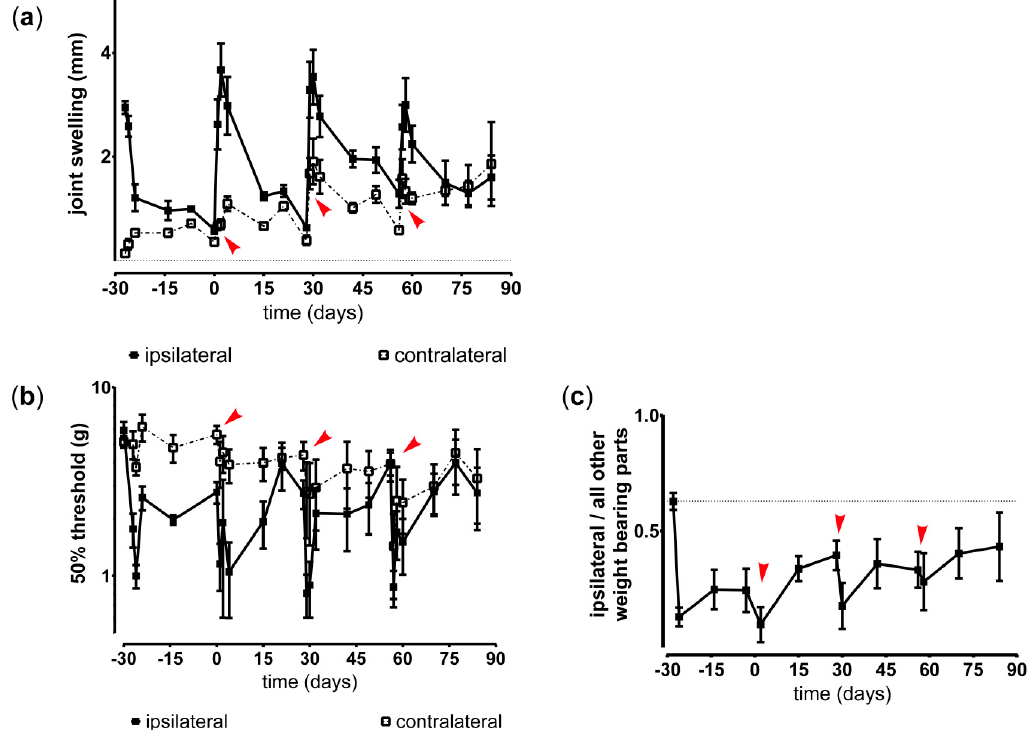
Figure 3. Inflammation and hyperalgesia induced by streptococcal cell wall peptidoglycan polysaccharide (PGPS) reactivations in a modified model enabling long-term monitoring of pain. ( a ) Joint swelling, as indication of inflammation, was measured in untreated affected (ipsilateral) and contralateral (contralateral) knee joints. PGPS reactivations on day 0, 28, and 56 are indicated by red arrows. ( b ) Withdrawal threshold of the induced mechanical hypersensitivity in untreated affected (ipsilateral) and contralateral (contralateral) knee joints. PGPS reactivations on day 0, 28, and 56 are indicated by red arrows. ( c ) Inflammation-induced changes in the ratio of weight bearing of the affected ipsilateral paw compared to the other weight bearing parts in untreated rats, reactivated with PGPS on day 0, 28, and 56, indicated by red arrows. All data represent mean ± standard deviation (SD).